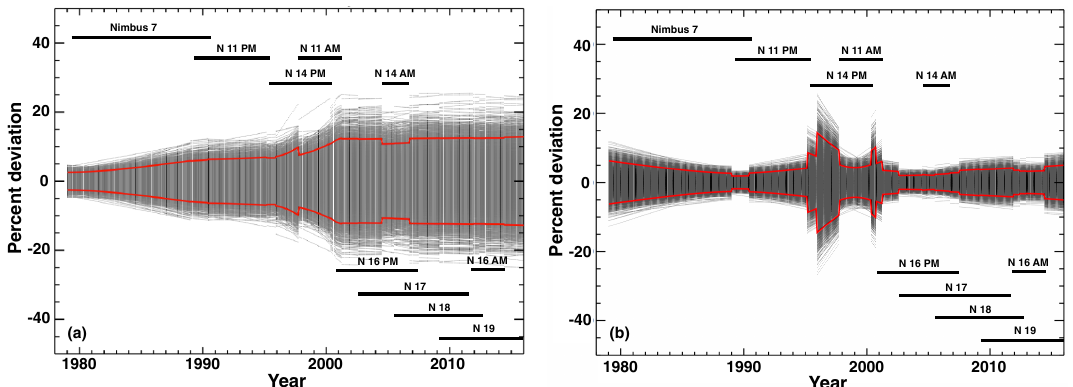
Figure 7. Two examples of Monte Carlo simulations used to model the propagation of uncertainty when merging data sets. Panel (a) shows a typical accumulation of uncertainty with each instrument added sequentially to the merged record. Panel (b) simulations use the same distribution of offset/drift values, but the timing reflects the cross-calibration done within the V8.6 algorithm relative to two baselines: NOAA 11 in the early 1990s and NOAA 17 in the mid-2000s. In both cases, periodic reductions in the error spread occur during periods when two or more instruments are averaged. In these examples only data included in MOD are